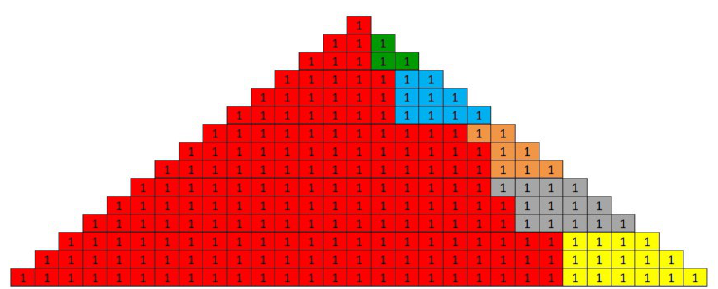
Figure 6. Need fulfillment degrees based on the expert opinions of state-own companies. Source: own study. Color markings as in Figure 3.